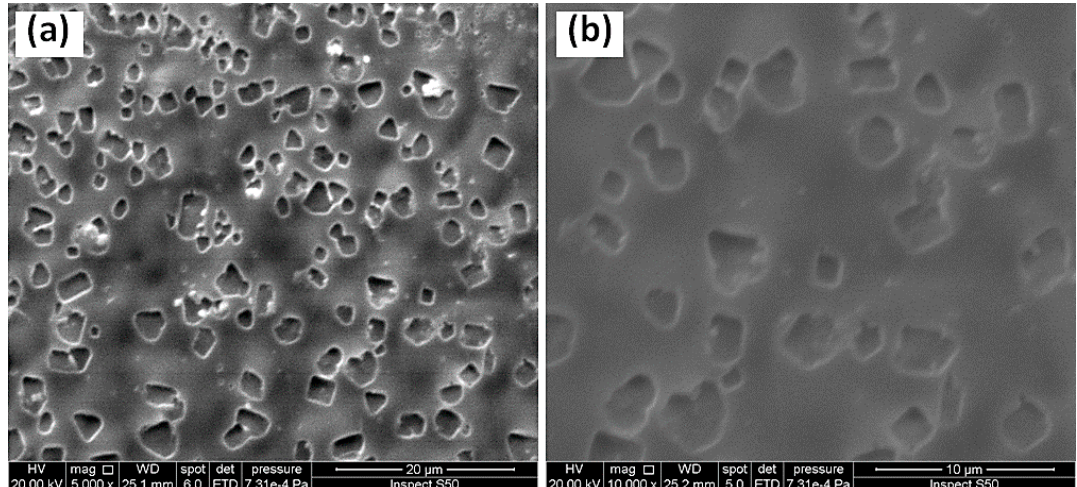
Figure 8. SEM images of PVC + 1 at: ( a ) 100 and ( b ) 20 μ m.